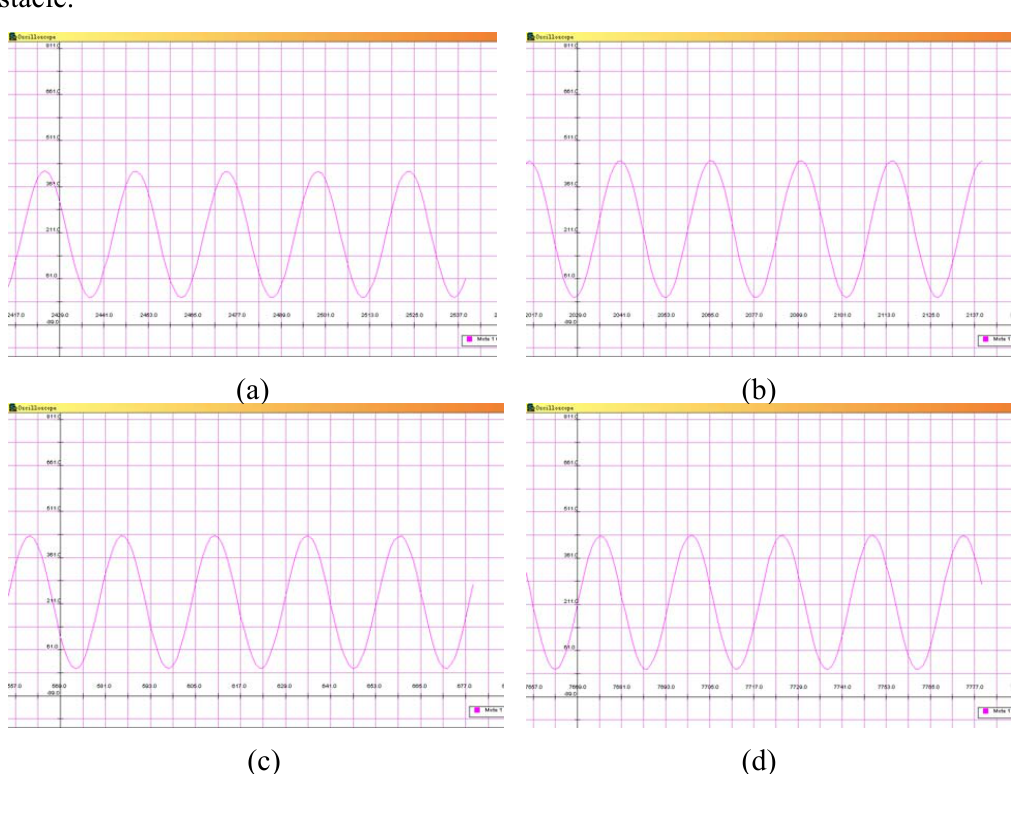
Figure 6. The received signals of the wireless sensor node in the test environment set by (a) no EMI factors, (b) a Bluetooth phone, (c) a GSM mobile phone and (d) five body